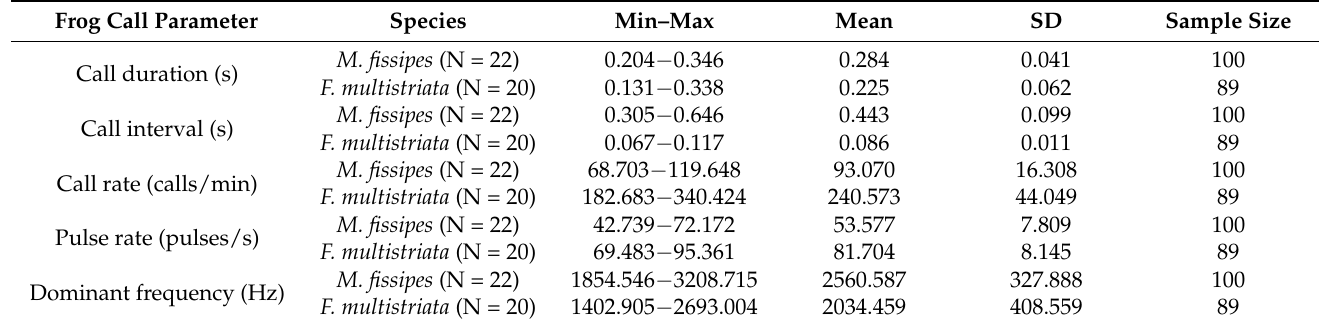
Table 2. Advertisement call parameters of M. fissipes and F. multistriata in 34 study sites along an urban–rural gradient in